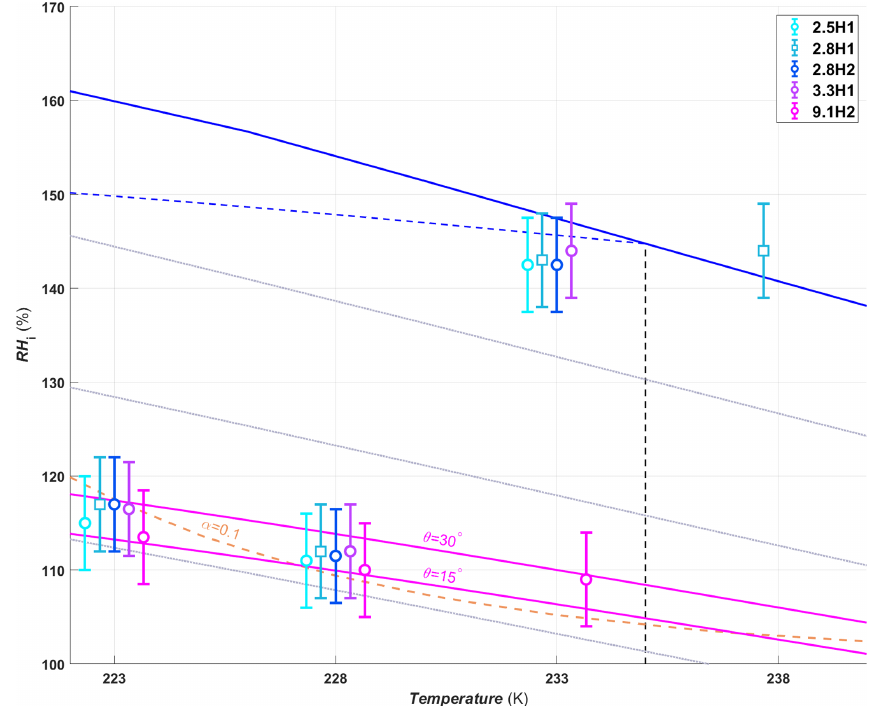
Figure 7. Average RH i required to reach an AF 0 . 05 for hydroxylated silica samples of different pore diameters. The symbols are offset by ± 0 . 3 or 0.6K from the experimental temperatures to make the points more visible. The pore filling lines are plotted for 9.1nm pores assuming a water contact angle of 15 and 30 ◦ (magenta lines). Symbols and reference lines are as in Fig.